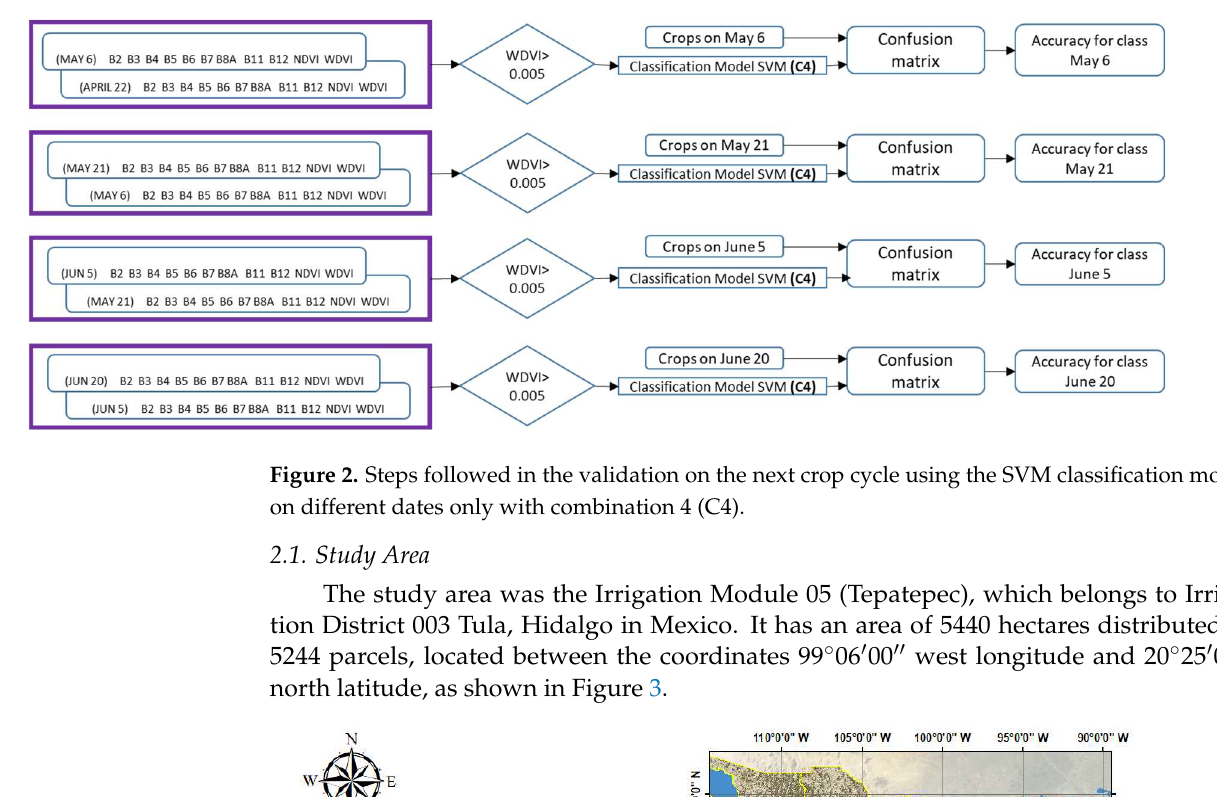
Figure 1. General overview of the methodology used to obtain the models for crop mapping.